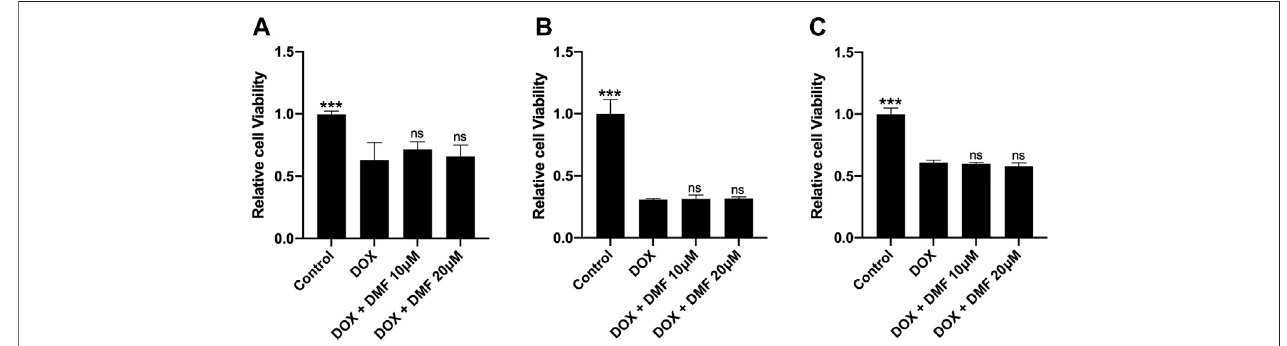
FIGURE 7 | Effects of DMF on antitumor ef fi cacy of DOX in some tumor cell lines. (A) Cell viability of SH-SY5Y cell line ( n = 4). (B) Cell viability of CT26. WT colon cancer cell line ( n = 4). (C) Cell viability of renal cell adenocarcinoma (Renca) cell line ( n = 4). All data were expressed by mean ± SD. *** p < 0.05 compared with DOX groups, ns (not signi fi cant).